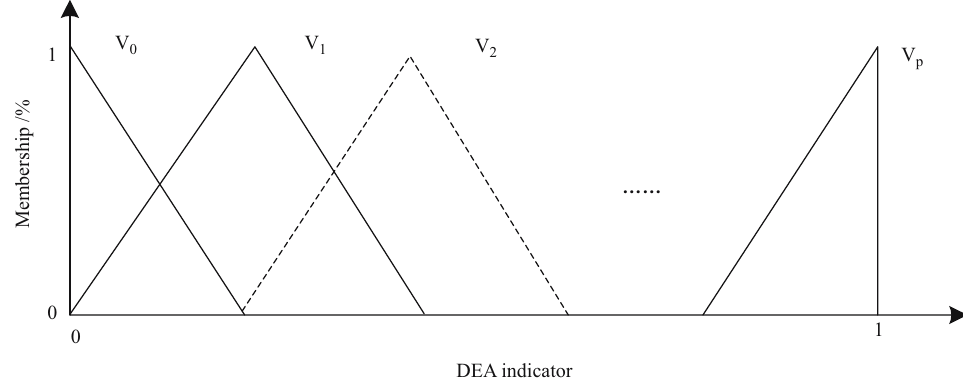
Figure 5: Membership function under fuzzy comprehensive evaluation.